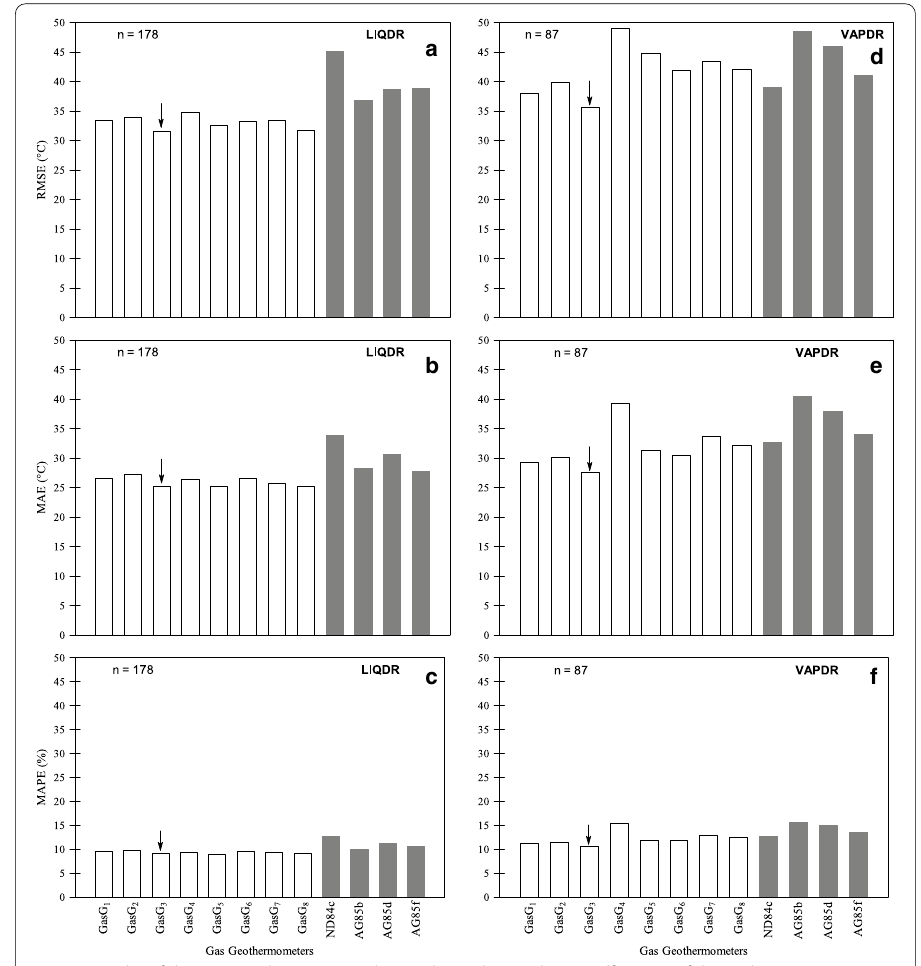
Fig. 7 Results of the statistical metrics used to evaluate the prediction efficiency of the eight new gas geothermometers against four existing geothermometers of the literature. The a – c plots show the residual results obtained for LIQDR wells (RMSE, MAE, and MAPE), whereas the d – f plots show the same residuals for VAPDR